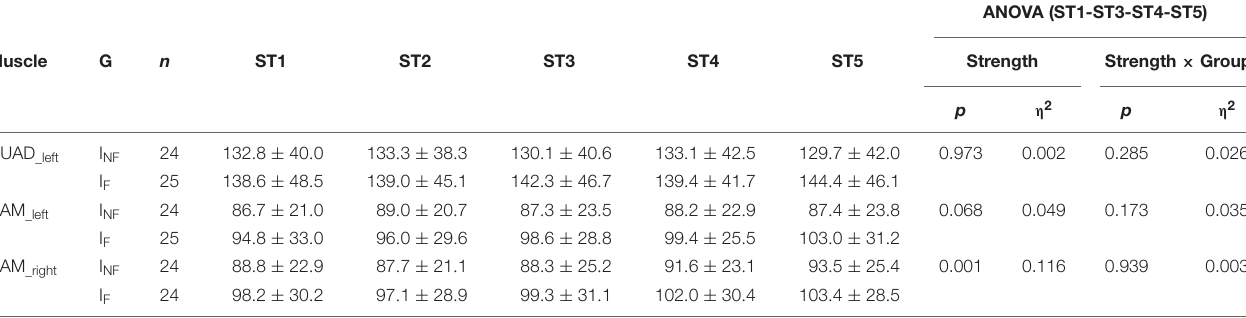
TABLE 3 | Concentric isokinetic strength test of recreational ski mountaineers during 5 days of ski mountaineering (ST1 to ST5).